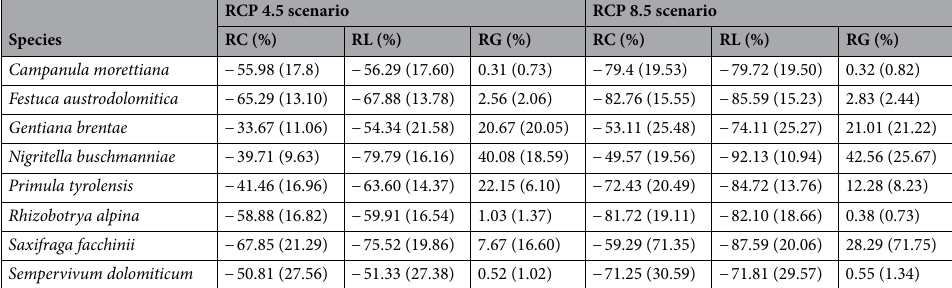
Table 2. Percentage of range change (RC), range loss (RL) and range gain (RG) under two future emission scenarios (intermediate rcp 4.5 and realistic rcp 8.5) for the eight study species. Standard deviation values are given in brackets